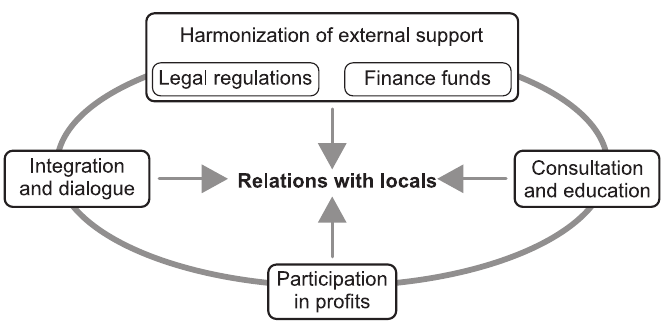
Fig. 5. Determinants of relations of biogas enterprises with the local structure. Source: own study based on research